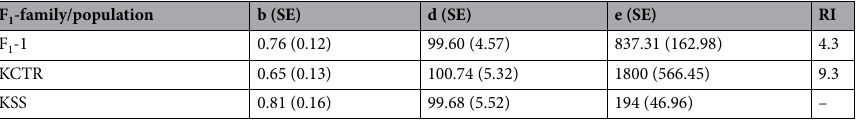
Table 1. Regression parameters describing the response of F 1 -1 progenies along with 2,4-D susceptible (KSS), resistant (KCTR) Palmer amaranth to 2, 4-D under growth chamber conditions (Eq.